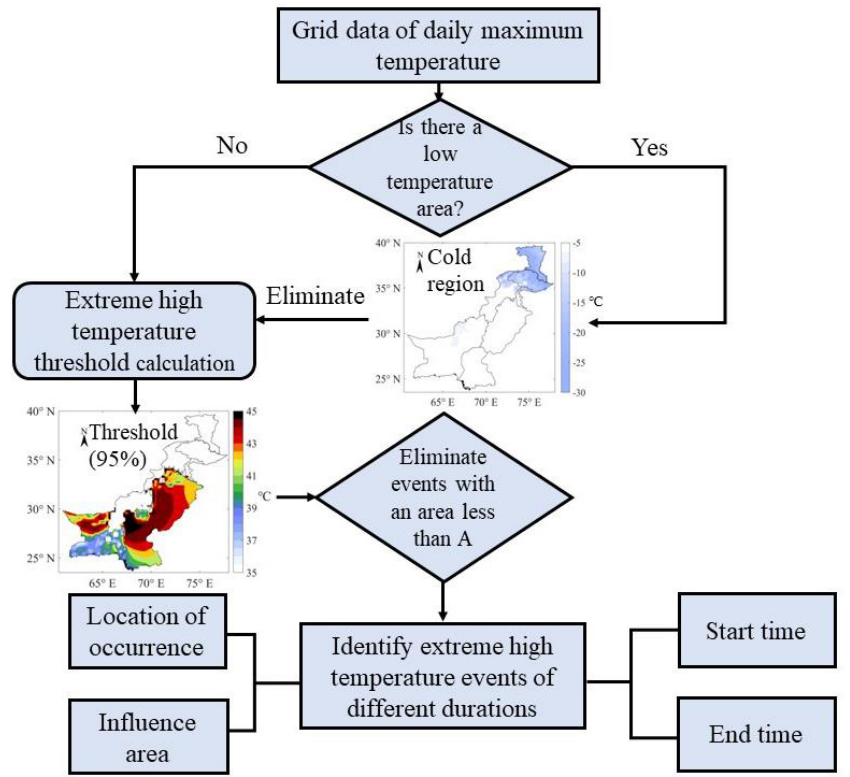
Figure 3. Extreme high-temperature events identification roadmap.